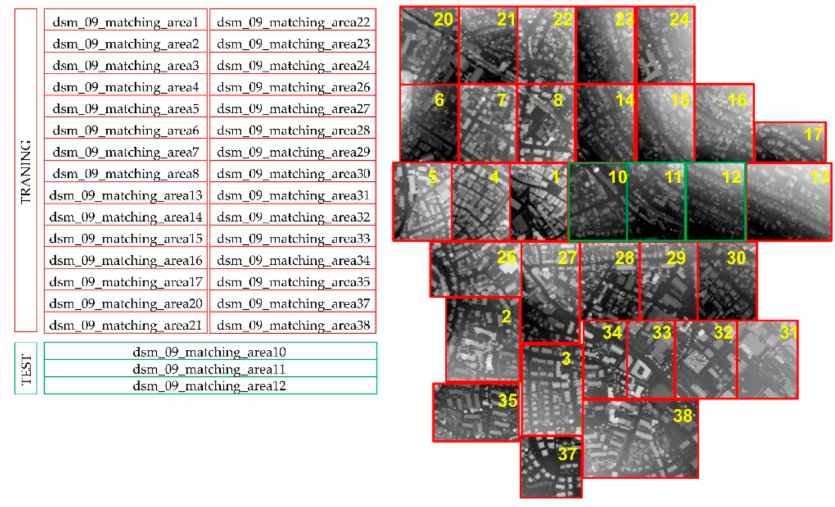
Figure 2. Digital surface model (DSM) patches of the Vaihingen an der Enz dataset: training (red) and test (green) subsets.